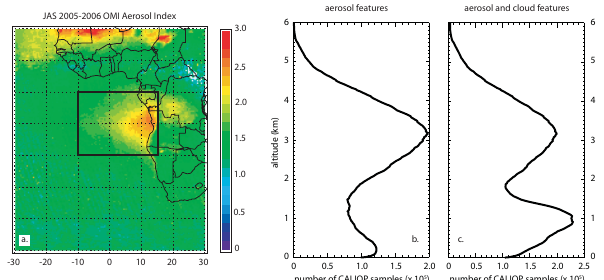
Fig. 1. (a) 2005–2006 July, August, and September average OMI aerosol index (from: Wilcox et al., 2009). (b) Vertical